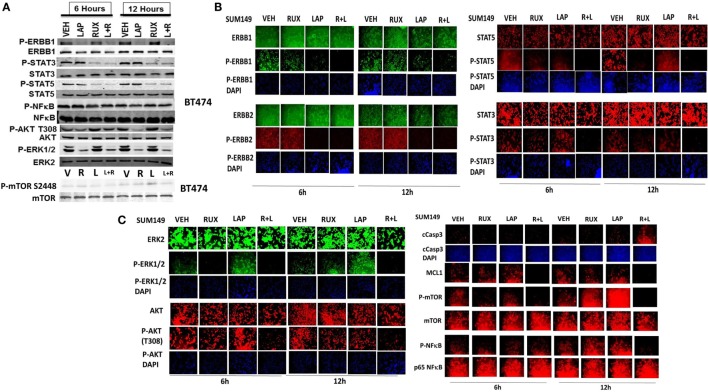
Lapatinib and ruxolitinib interact to inactivate AKT, mTOR, STAT3, STAT5, and ERK1/2 as judged by western blotting. (A) BT474 cells were treated with vehicle control, ruxolitinib (1.0 μM), lapatinib (1.0 μM) or the drugs in combination for 6 h and for 12 h. At each time point cells were lysed with RIPA buffer and clarified by centrifugation. Ten milligram of protein from each lysate was subjected to SDS-PAGE on 10% gels. Proteins were transferred to 0.2 μm nitrocellulose and probed with antibodies generated against the indicated proteins and phospho-proteins. Bands were imaged using a first generation Odyssey Infra-Red imager at 300 dpi. (n = 3 ± SEM). (B,C) SUM149 cells were treated with vehicle control, ruxolitinib (1.0 μM), lapatinib (1.0 μM), or the drugs in combination for 6 h and for 12 h. At each time point, cells were fixed in place and permeabilized using 0.5% Triton X100. Immuno-fluorescence was performed on native proteins to detect the total expression and phosphorylation levels of ERBB1, ERBB2, STAT3, STAT5, ERK1/2, AKT T308, mTOR S2448; NFκB p65 S536, MCL-1, and cleaved caspase 3 (cCasp3) (n = 3 ± SEM).